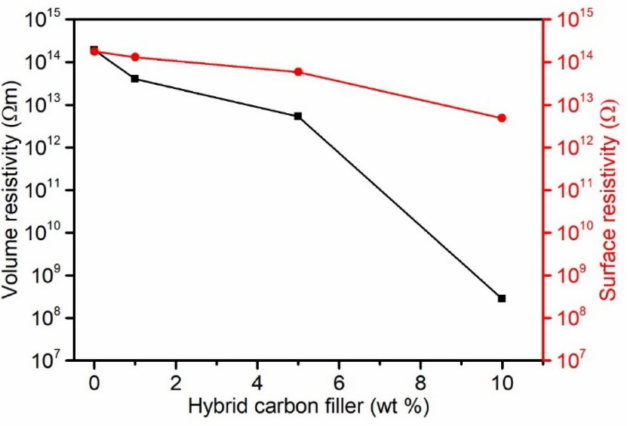
Figure 10. Volume and surface resistivity of PVC materials as a function of hybrid filler